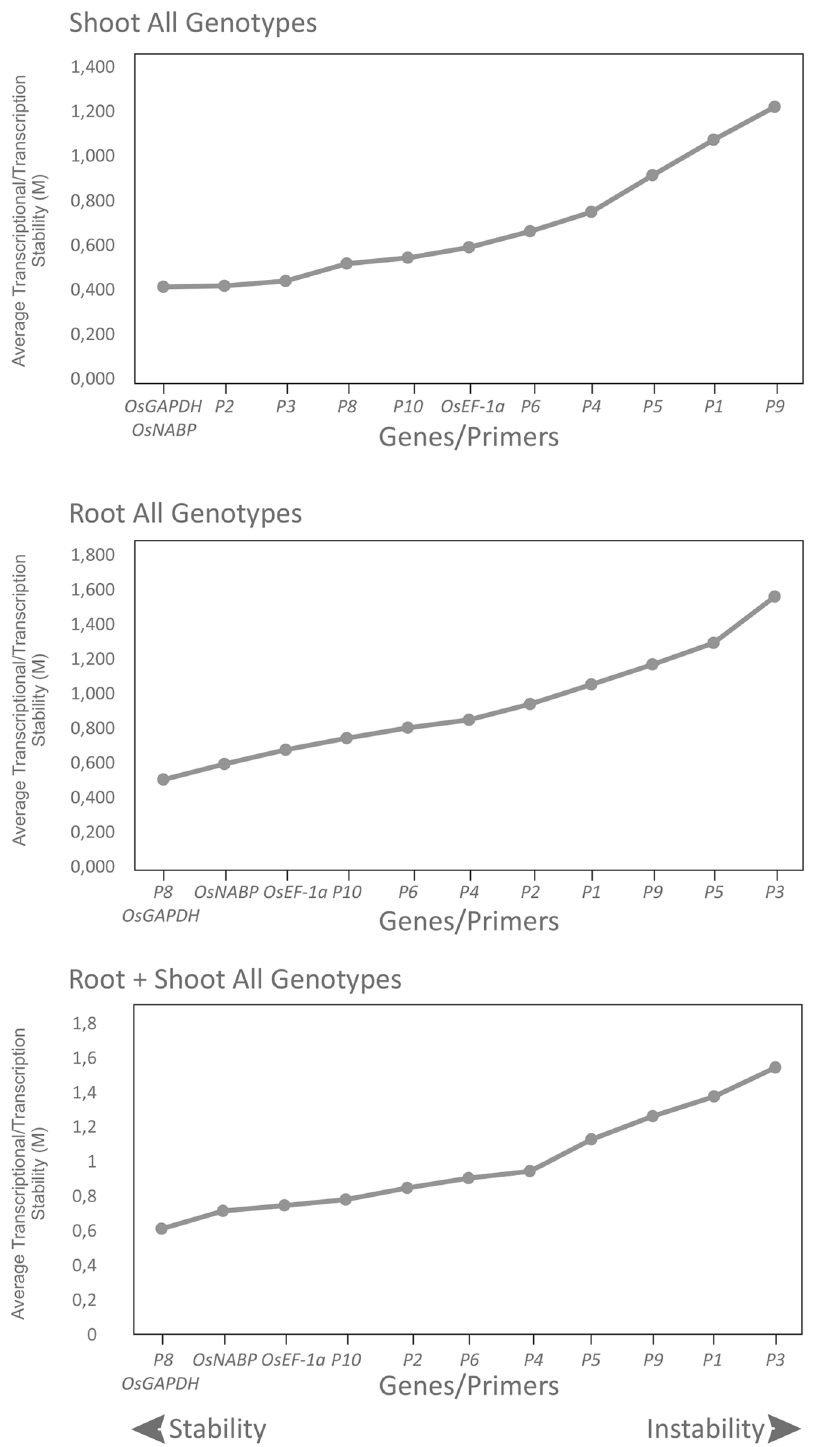
Fig 2. Transcriptional stability of the candidate reference genes investigated by geNorm. The candidate reference genes, OsEF-1a (Os03t0177500-01), P1 (Os01t0220700-00), P2 (Os01t0252200-01), P3 (Os01t0654300-01), P4 (Os01t0759500-01), P5 (Os05t0352700-00), P6 (Os07t0644200-01), P8 (Os09t0560400-01), P9 (Os10t0378400-01), P10 (Os12t01119600-00), GAPDH (Os04t0606400-02), and OsNABP (Os06g0215200) were evaluated in shoots and roots of one japonica (Nipponbare) and two contrasting indica (Epagri 108 and IRGA 409) cultivars subjected to iron treatment (500 mg L -1 FeSO 4 .7H 2 O at pH 4.0 ± 0.1), for 0, 12, 24 and 36 hours.